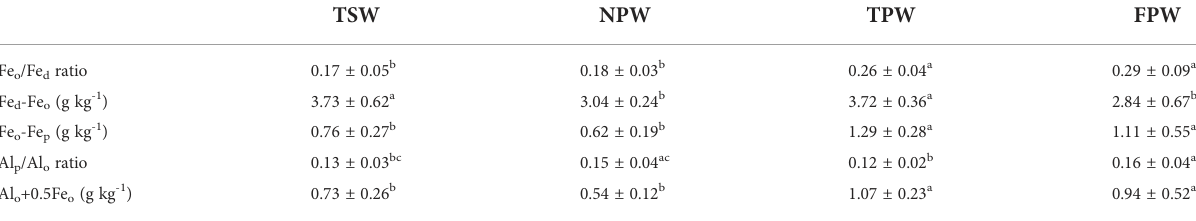
abc Different letters represent signi fi cant differences ( p < 0.05) between sampling